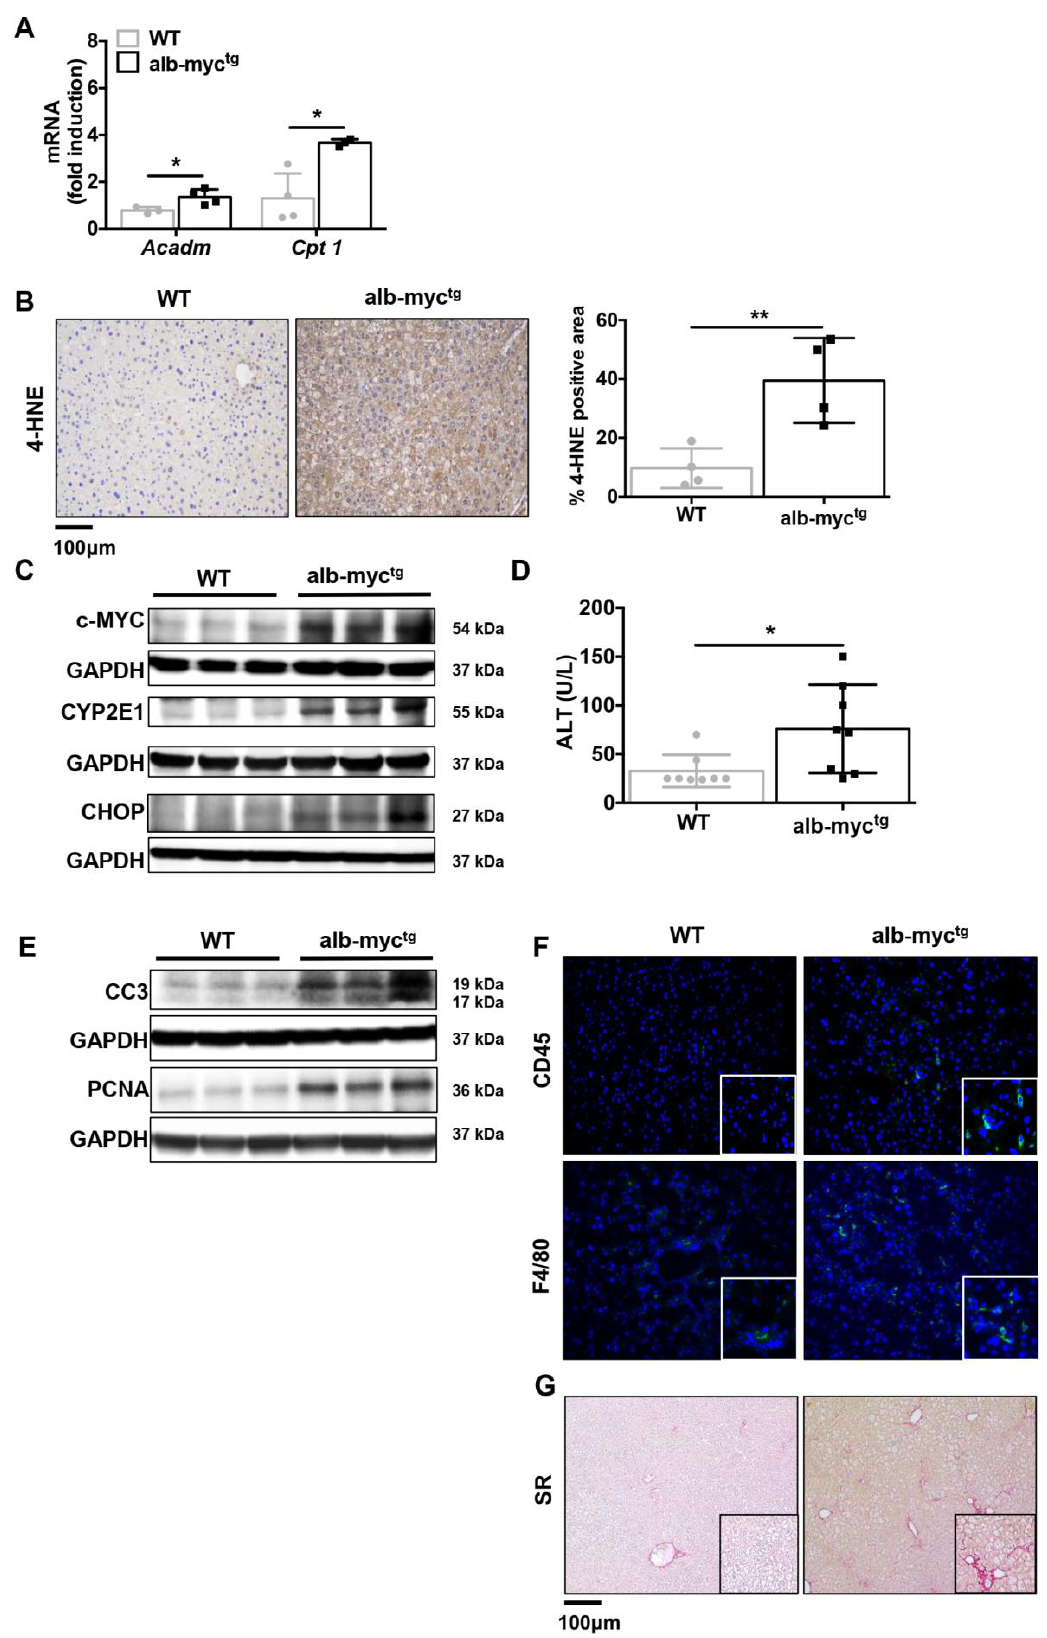
Figure 4. Transgenic overexpression of c-MYC in the livers leads to induction of ER stress, apoptosis, inflammation and fibrosis. ( A ) qPCR analysis of hepatic mRNA expression of Acadm and Cpt1